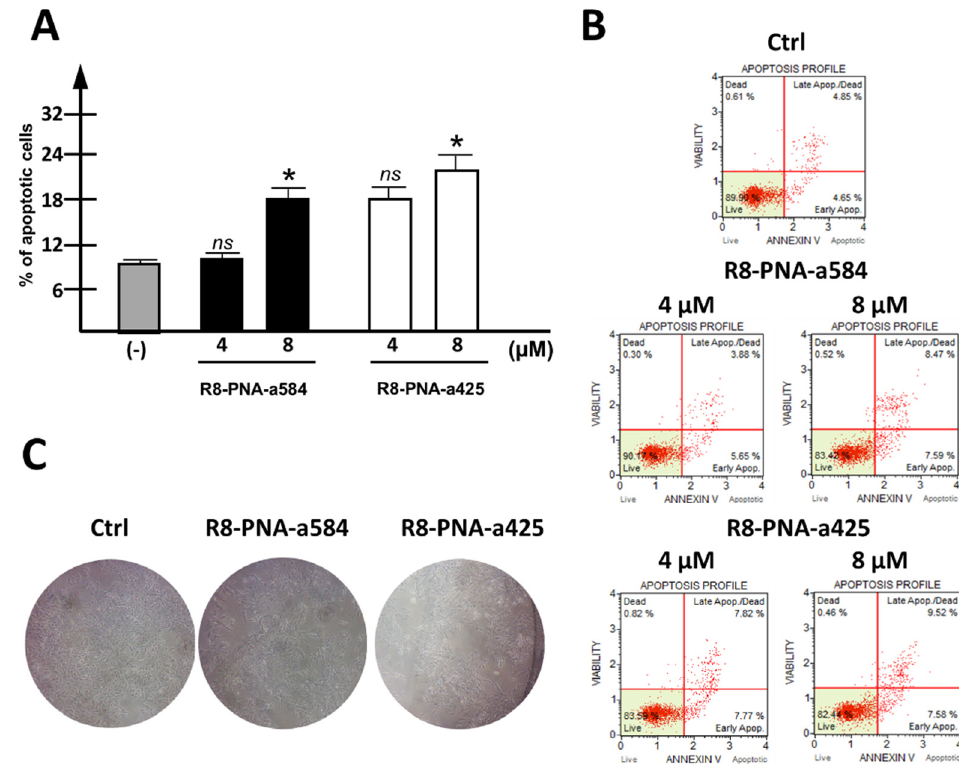
Figure 3. Effects of R8-PNA-a425 and R8-PNA-a584 on apoptosis. ( A ) Effects of anti-miRNA PNAs on apoptosis induction in HT-29 cells treated for 72 h with 4 or 8 µM R8-PNA-a584 (black boxes) or R8-PNA-a425 (white boxes). ( B ) Representative plots of the apoptotic profile are reported. ( C ) Representative pictures showing the morphological appearance of HT-29-treated cells are reported. (* p < 0.05, ns: not significant; n = 3 independent experiments).